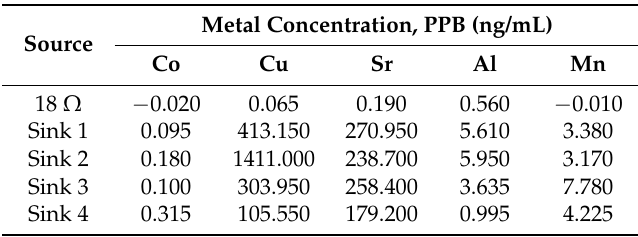
Table 2. Metal concentrations in lab sink